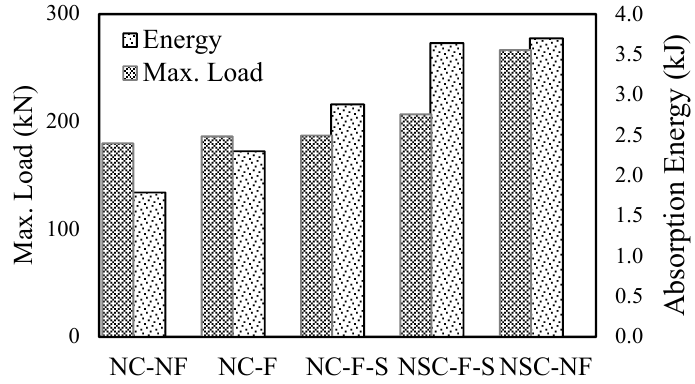
Figure 6. Energy dissipation capacity at first blow.